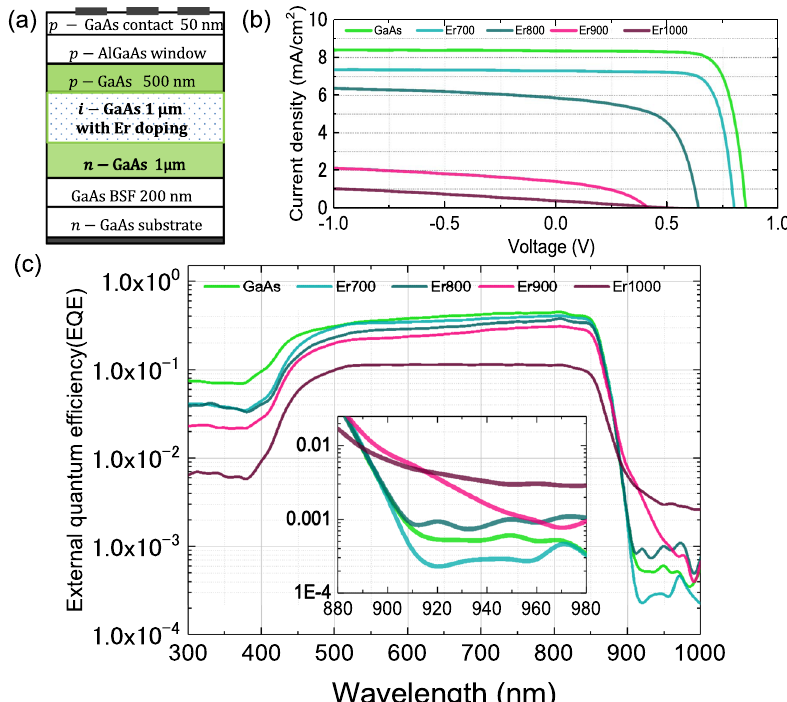
Fig. 3 Schematic device structure and measured current density ( J ) – voltage (V) curves. a Energy-transfer ratchet IBSC (ETR-IBSC) structure based on Er-doped GaAs, b J – V curves obtained under 1 sun illumination with an AM1.5 spectrum, and c external quantum ef fi ciency spectra of all fi ve devices under a bias voltage of − 5 V,